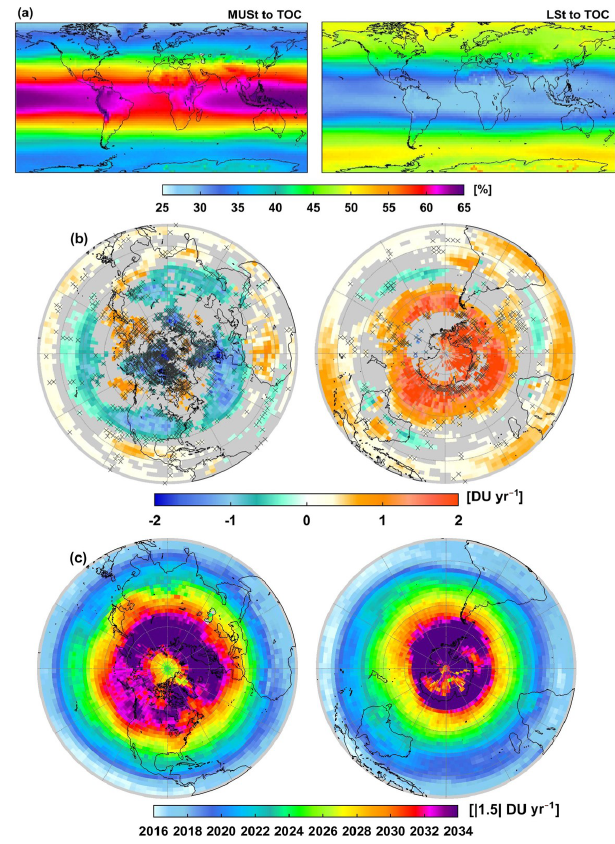
Figure 9. Global distribution of (a) the contribution (in percent- age) of MUSt and LSt into the total O 3 (left and right panels re- spectively) averaged over January 2008–December 2017, (b) fitted trends in total O 3 (in DUyr − 1 ; the grey areas and crosses refer to the non-significant grid cells in the 95% confidence limit) and (c) estimated year for the detection of a significant trend in total O 3 (with a probability of 90%) for a given trend of | 1 . 5 | DUyr − 1 starting on January